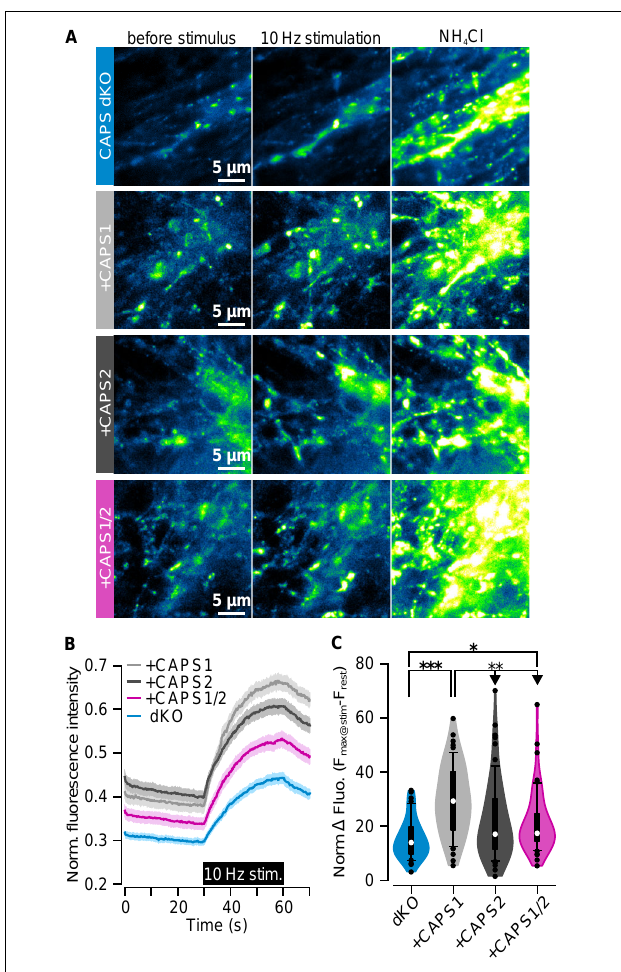
FIGURE 8 | CAPS1/2 chimera partially rescues SV exocytosis. (A) CAPS dKO DRG neurons were isolated from E18/19 mice, infected with lentiviruses encoding for SypHy and either CAPS1-Halo, CAPS2b-Halo, or CAPS1/2 chimera-Halo and co-cultured with WT SC neurons for 8 days. Displayed from left to right are representative images of SypHy signal in DRG neurons before and during 10 Hz field electrode stimulation and upon NH 4 Cl application for full de-quenching of SypHy vesicular pool. From top to bottom are representative CAPS dKO neurons that were or were not co-transfected with either CAPS1, CAPS2b, or the CAPS1/2 chimera construct. (B) Normalized SypHy signal at synapses in response to electrical stimulation for CAPS dKO neurons (blue), expressing CAPS1 (light gray), CAPS2b (dark gray), or CAPS1/2 chimera (magenta). SypHy fluorescence intensity of each synapse was normalized to its fluorescence intensity during NH 4 Cl application. Data are mean ± SEM. (C) Violin plot of the maximum normalized SypHy fluorescence intensity increase at each synapse elicited by 10 Hz electrical stimulation. Experiments were performed on a minimum of three independent cultures for every genotype. Number of measured synapses from either native CAPS dKO neurons or expressing either CAPS1, CAPS2b, or CAPS1/2 chimera was 45, 53, 64, and 58, respectively, in more than 3 independent experiments. * p < 0.05, ** p < 0.01, or *** p < 0.001 ANOVA on rank with Dunn’s post hoc